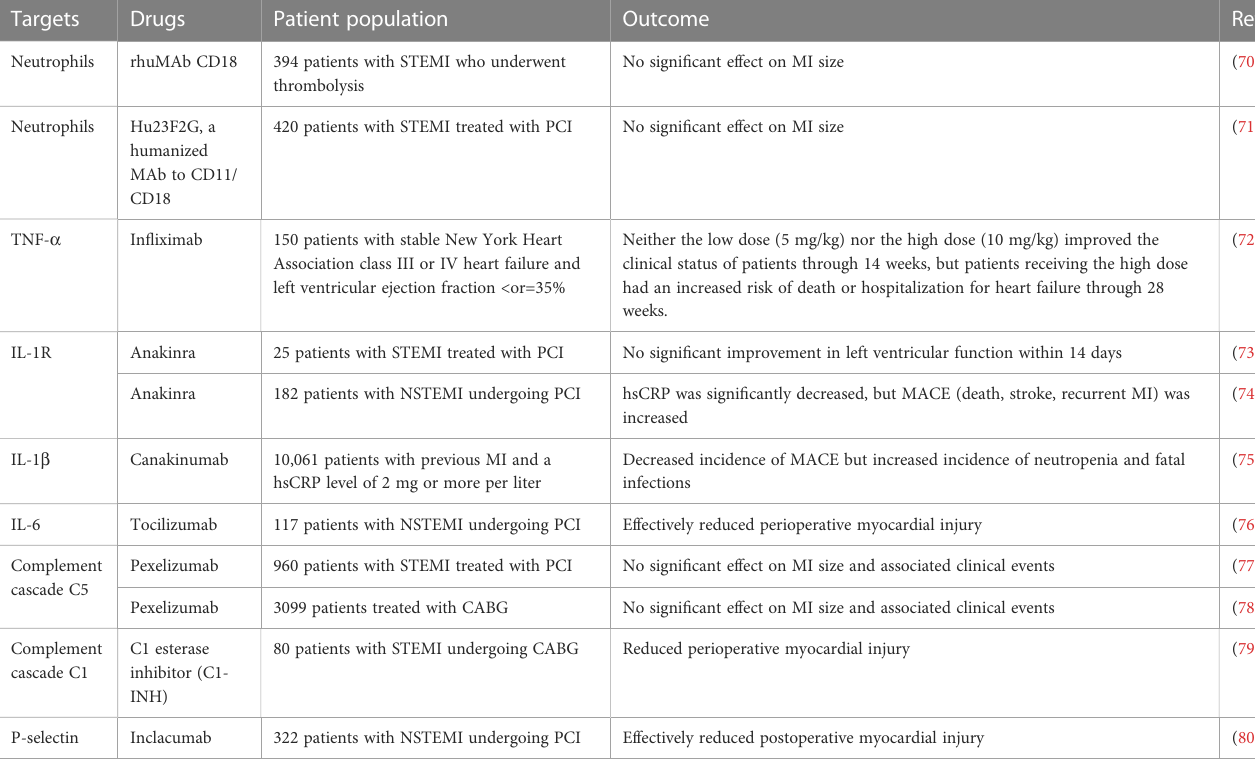
TABLE 2 Results of several major clinical studies based on immunomodulatory protection against myocardial ischemia. Targets